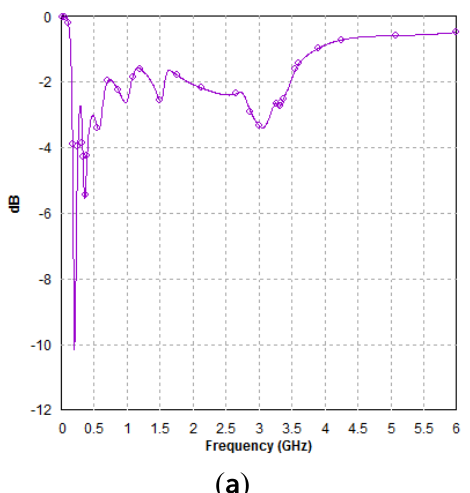
Figure 22. Simulated RL ( a ), and radiation patterns, E-Total ( b ) of the